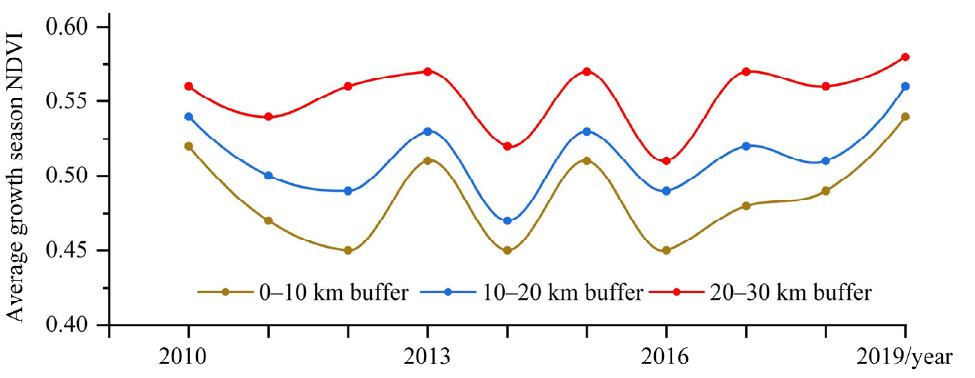
Figure 3. Changes in average growth season Normalized Difference Vegetation Index (NDVI gs ) in three buffer zones along the National Highway G214 from the Changshitoushan Mountain Pass to the Qingshui’he Riverside at the northern and southern flanks of the Bayan Har Mountains on the southern Qinghai Plateau, West China, from 2010 to 2019.